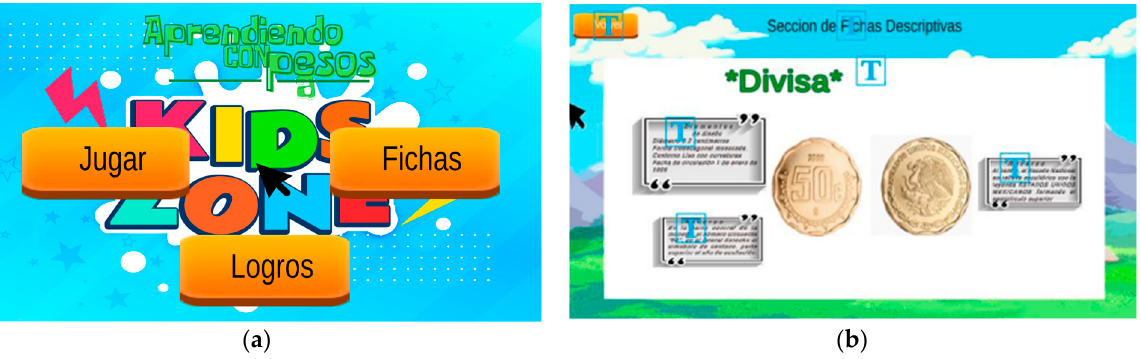
Figure 5. ( a ) Main interface of “Learning with Pesos” application. ( b ) Descriptive cards section showing information about a 50c coin. showing information about a 50c